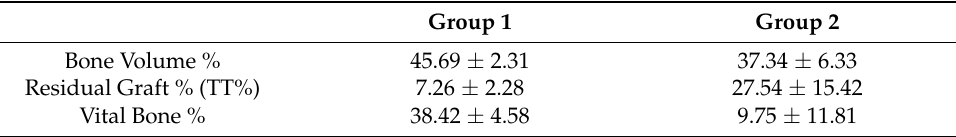
Table 1. Histomorphometric parameters of Group 1 (dentin graft + membrane) and Group 2 (dentin graft